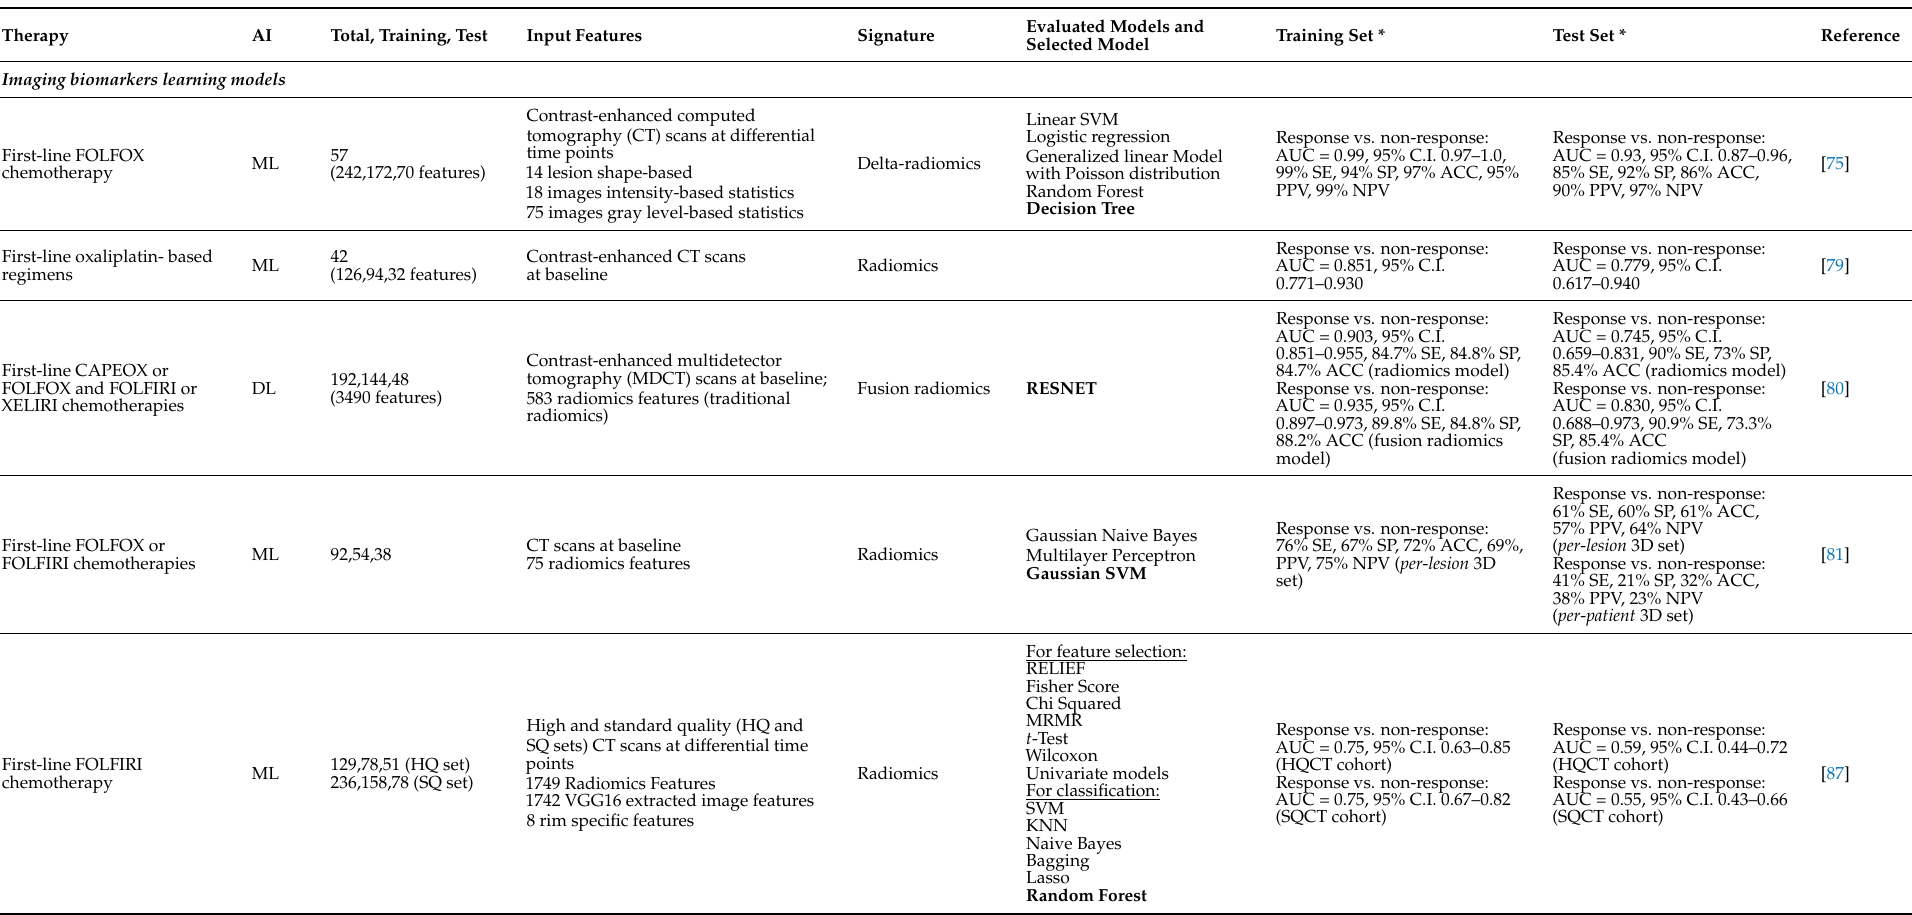
Table 2. Artificial intelligence analysis of the response to standard chemotherapy alone for patients with colorectal metastasis. Data are grouped for imaging or molecular or clinical biomarkers based learning